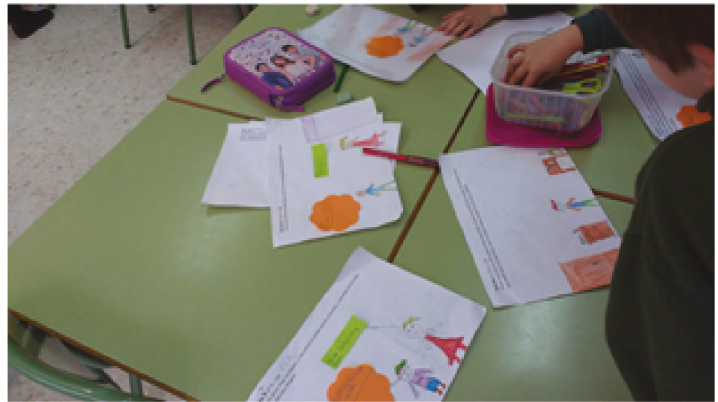
Figure 21: Scenes created by children in the second intervention (primary